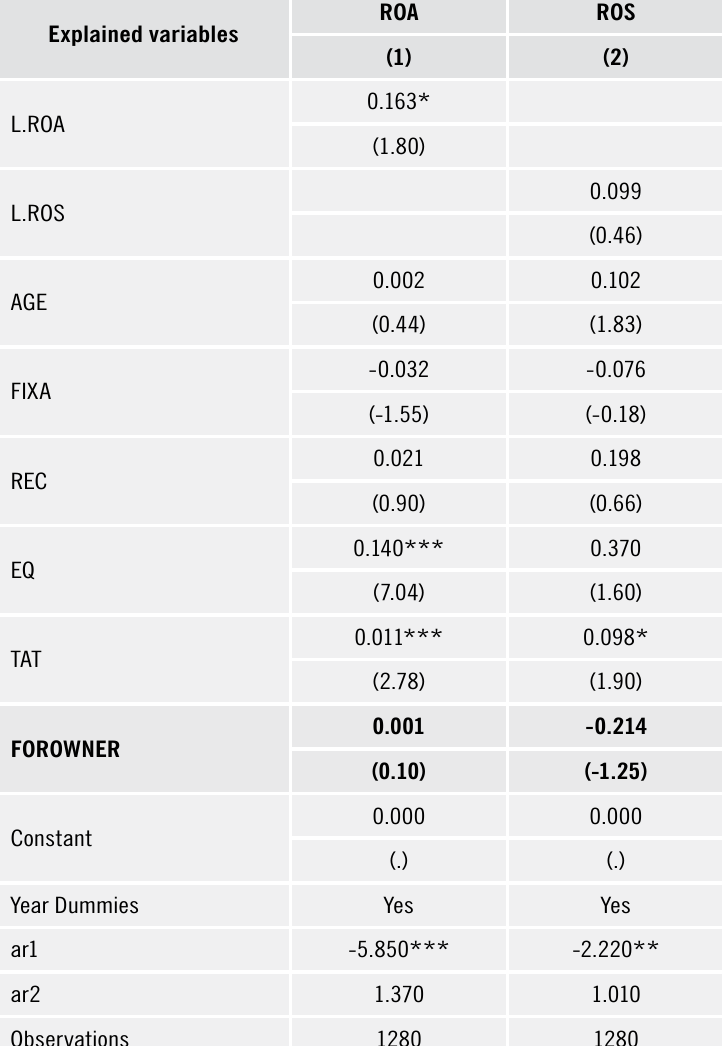
Table 12. Dynamic panel analysis of empirical relationship foreign ownership share and firm contemporaneous ROA &